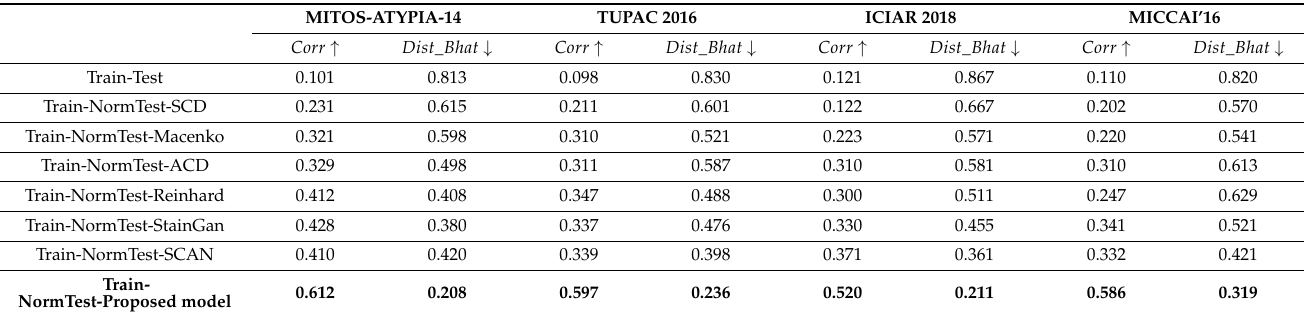
Table 5. Train-Test datasets color consistency analysis in terms of histogram correlation and Bhat- tacharyya distance using the proposed technique with other state-of-the-art